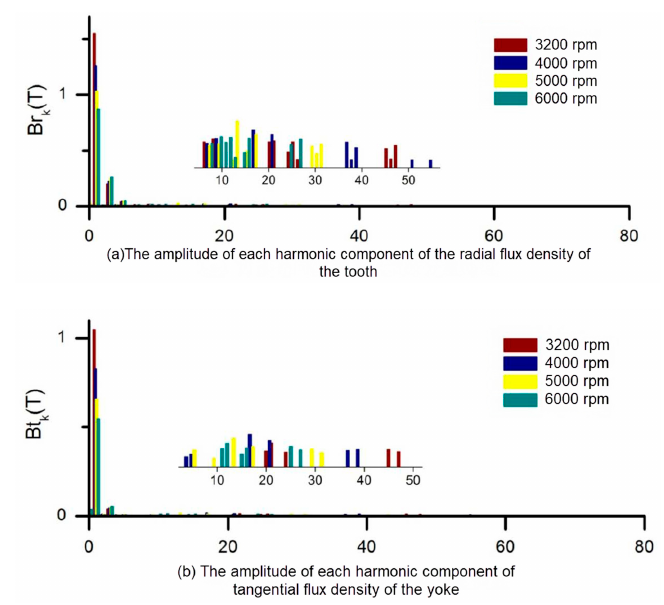
Figure 17. The amplitude of each harmonic component of the tooth radial flux density and yoke tangential flux density under SVPWM. Table 4. Stator core loss under sinusoidal current source and SVPWM.